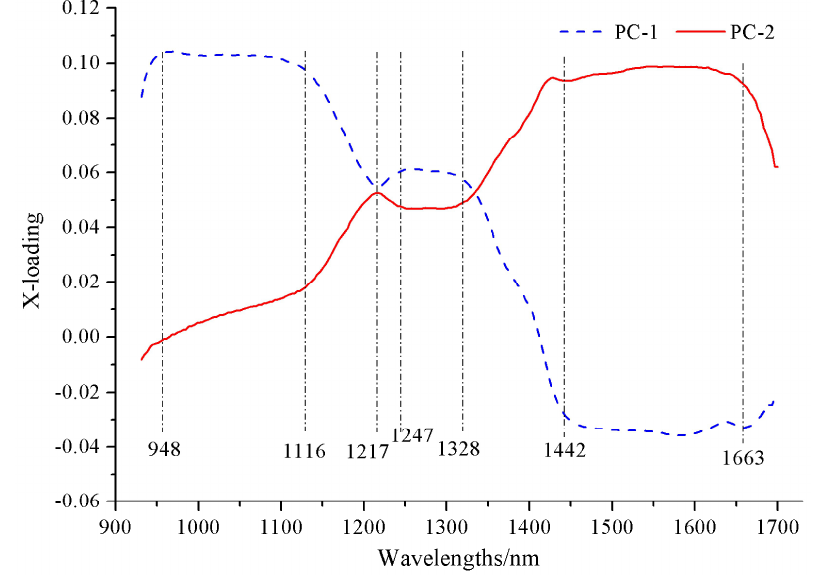
Figure 6. The X-loading plots of first two PCs of the principal component analysis (PCA).